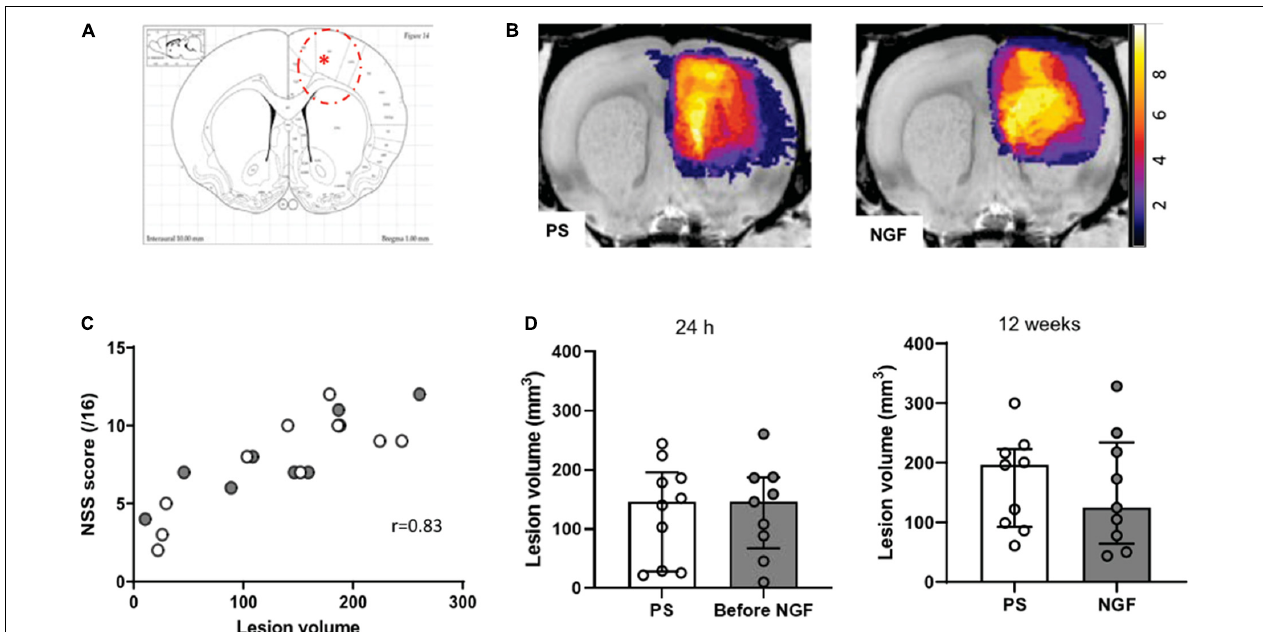
FIGURE 4 | Characterization of the lesion. (A) Coronal section corresponding to the malonate injection site (red asterisk) and lesion size (red dashed line), adapted from Paxinos Atlas. (B) Representative T2-weighted MRI color-coded images showing the localization of the lesion in the two groups of rats (PS: left panel ; NGF: right panel ). The panels show the overlap map of injured voxels, providing an overview of the lesioned brain areas 24 h after the injection of malonate for the groups. Color indicates the number of rats injured at each voxel. (C) Graph showing the correlation between the lesion volume 24 h after the injection of malonate and motor deficits (NSS score) measured 48 h post-injury ( p < 0.0001). (D) Notch box plots showing the distribution of lesion volumes, expressed in mm 3 , 24 h ( left ) and 12 weeks ( right ) post-injury. PS group: n = 9; NGF group: n = 9. PS: physiological saline; NGF: nerve growth factor; NSS: neurological severity scale; MRI: magnetic resonance